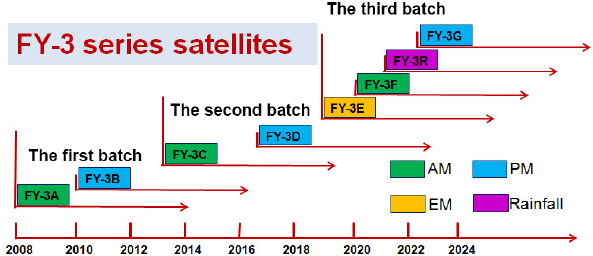
Figure 1. Timeline of FY-3 series satellites. The FY-3 series satel- lites are the Chinese second-generation polar-orbiting meteoro- logical satellites including AM (morning), PM (afternoon), and EM (evening) orbits, and rainfall types of satellites, which have been/will be launched in three batches (source: Sun et al., 2017).